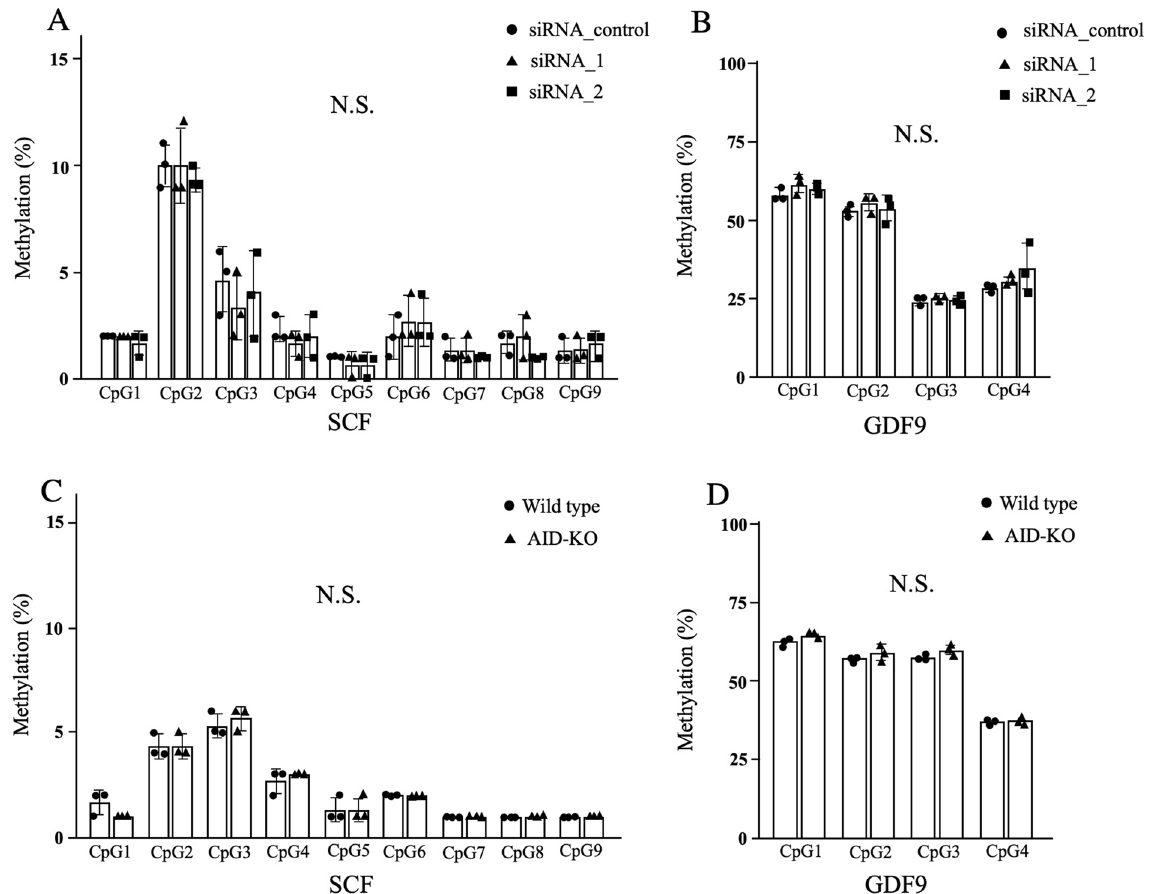
Figure 6. DNA methylation profiles of SCF and GDF-9. ( A – D ) The DNA methylation profiles of SCF and GDF-9 using cultured granulosa cells ( A , B ) and ovarian tissues ( C , D ). In the granulosa cell culture, there were no significant differences in methylation profiles of SCF ( A ) and GDF-9 ( B ) among si-RNA-control, siRNA- AID_1, and siRNA-AID_2 groups. There were also no differences in methylation profiles of SCF ( C ) and GDF-9 ( D ) in the ovarian tissues between wild-type and AID-KO